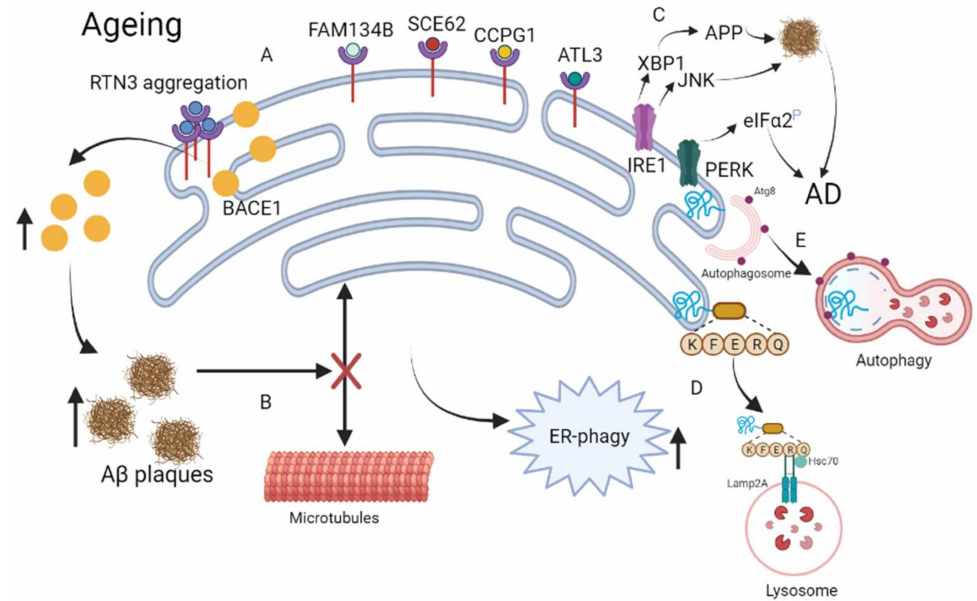
Figure 3. Reticulophagy in the pathogenesis of AD. ( A ) RTN3 aggregation counteracts the negative regulation of BACE1 activity by RTN3, causing A β to increase in the aging brain. ( B ) Deposition of A β inhibits the interaction of the ER and microtubules, inducing reticulophagy. ( C ) ER stress/AD factors increase misfolded proteins through the IRE1 and PERK pathway. ( D ) KFERQ binds with impaired ER for CMA degradation. ( E ) Autophagosomes wrap the impaired ER for